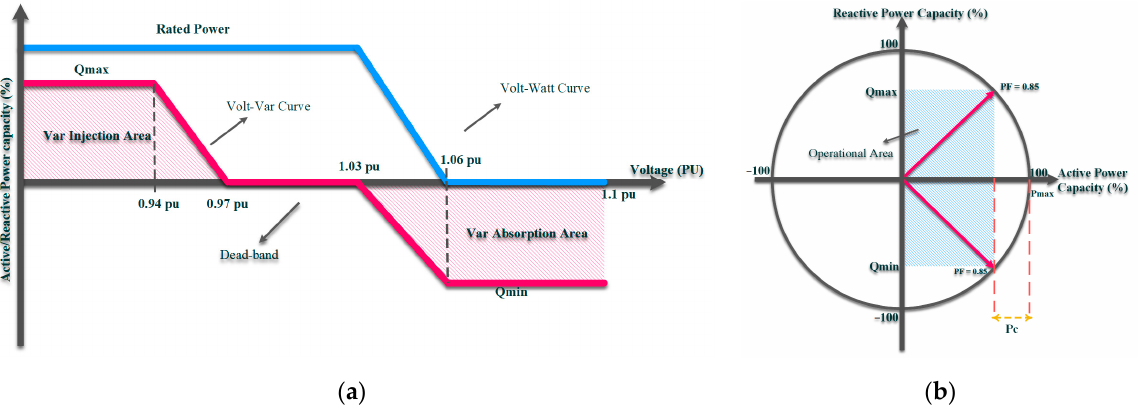
Figure 5. Smart inverter’s characteristics: ( a ) smart inverter’s volt–var and volt-watt curves; ( b ) smart inverter’s operational area.